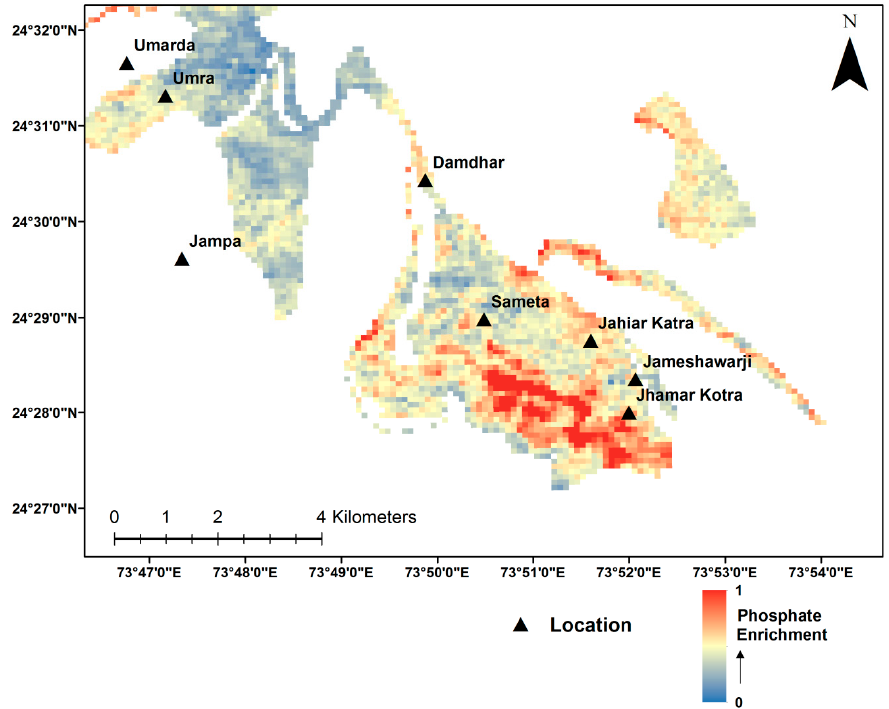
Figure 12. Density sliced relative band depth image derived using three emissivity bands of ASTER (Band 13+Band 11)/Band 12. Relative subpixel abundance of phosphate is increasing with yellow to red color, while blue zones are dolomite.